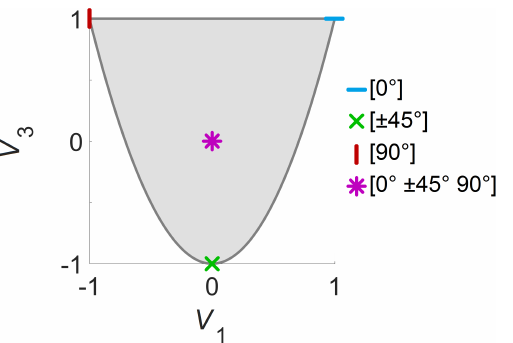
Figure 2. Feasible region of lamination parameters and sample design points with corresponding layer